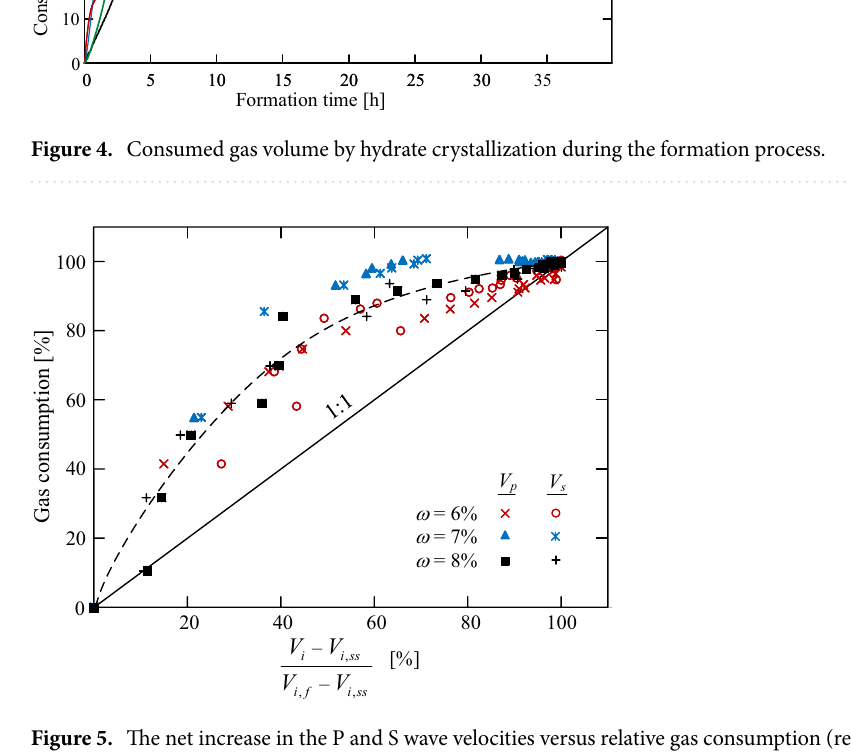
Figure 5. The net increase in the P and S wave velocities versus relative gas consumption (relative to the final consumed gas